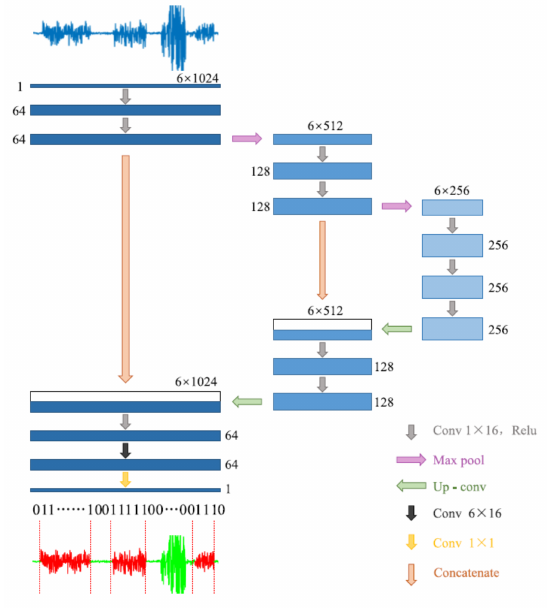
Figure 2. The architecture of the DCNN model. Adapted from Zou et al. (2020) [31].